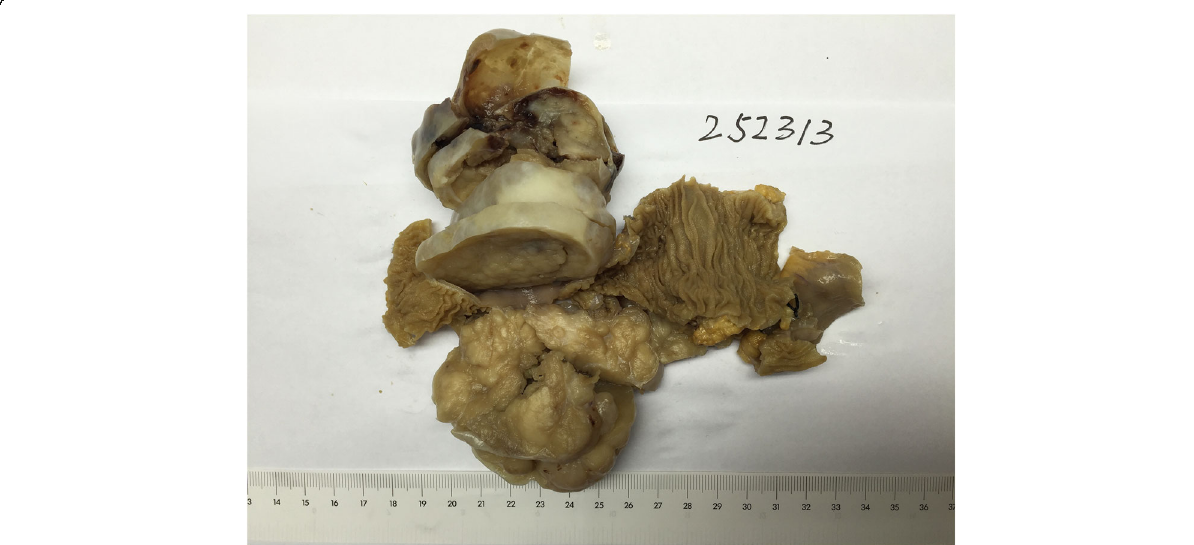
Dual color break-apart probe FISH examination showed that 90% of the cells (100 counted cells per slide) exhib- ited 1 yellow and 1 red signal (1F1R) and that 6% of the cells exhibited 1 yellow, 1 red and 1 green (break-apart) signal (1F1G1R). However, only 4% cell had two yellow signals, which proved a break of the EWSR1 locus (2 F) (Fig. 4a-c).